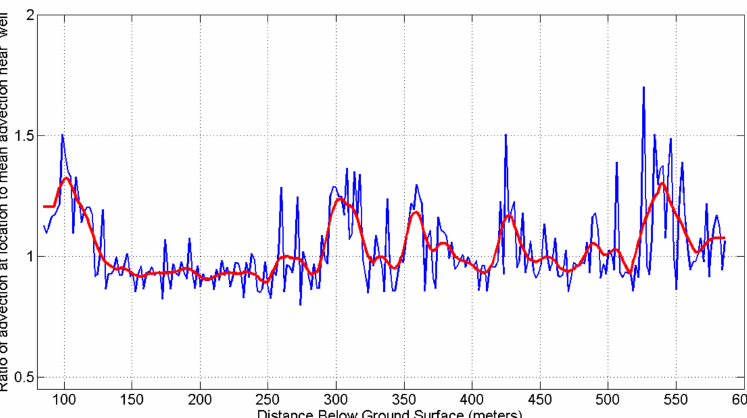
Figure 9. Estimates of relative advective flows for each location along the cable (blue line) from Equation 3, with τ C1 the time for location temperatures to diverge by 30% from temperatures expected with pure conduction, and τ C2 the mean time to diverge by 30%. Smoothing the data (red line) suggests there are several intervals along the well that may have higher rates of advection (e.g., 150–175 m; 370–385 m; and 590–620 m).